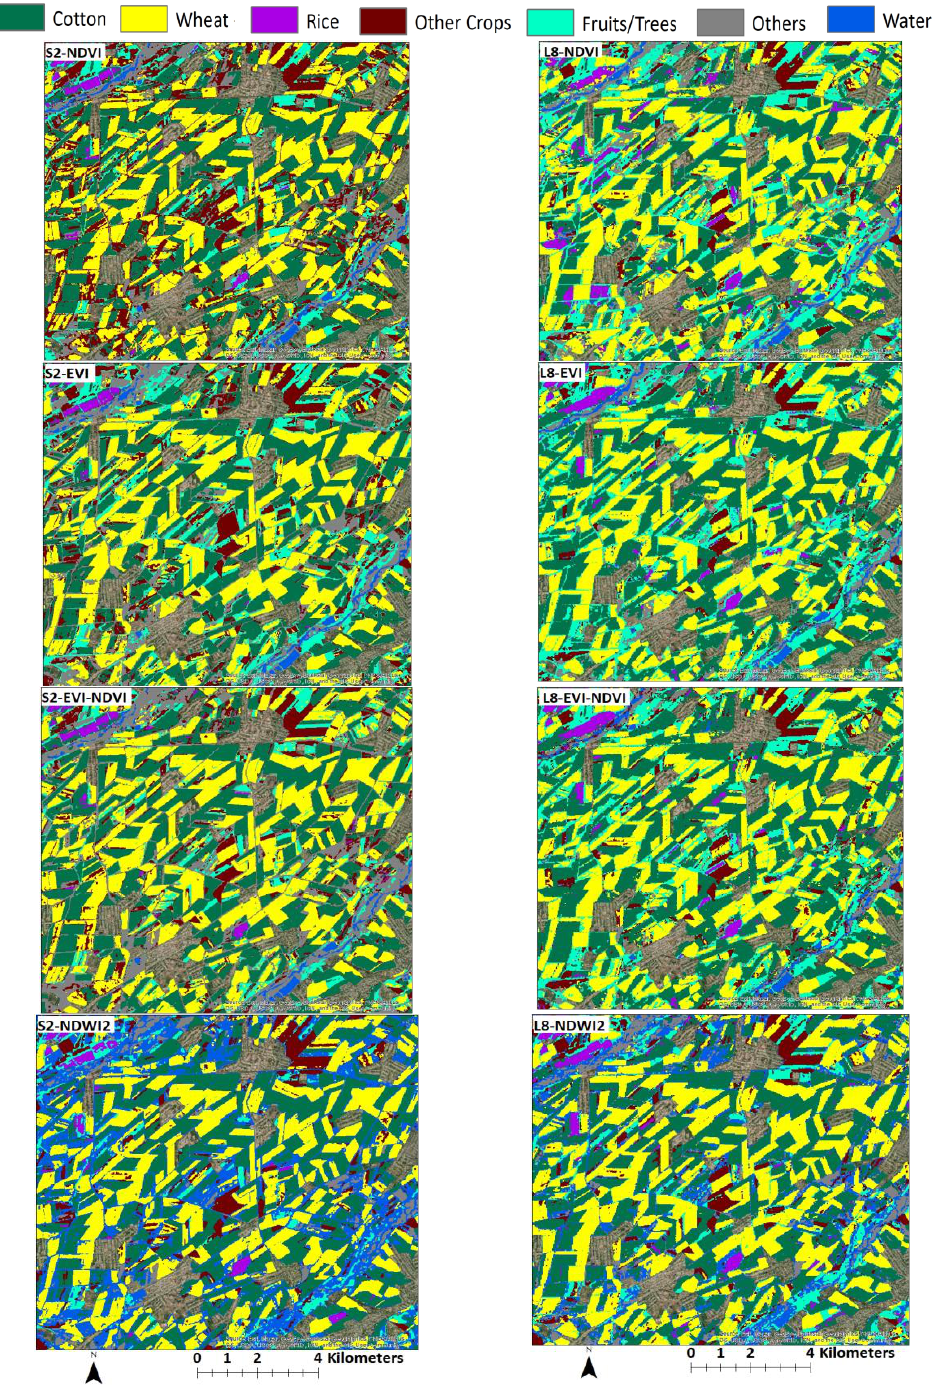
Figure 11. Subsets of LU maps derived from different indices using the RF classification method for both S2 ( left ) and L8 ( right ).